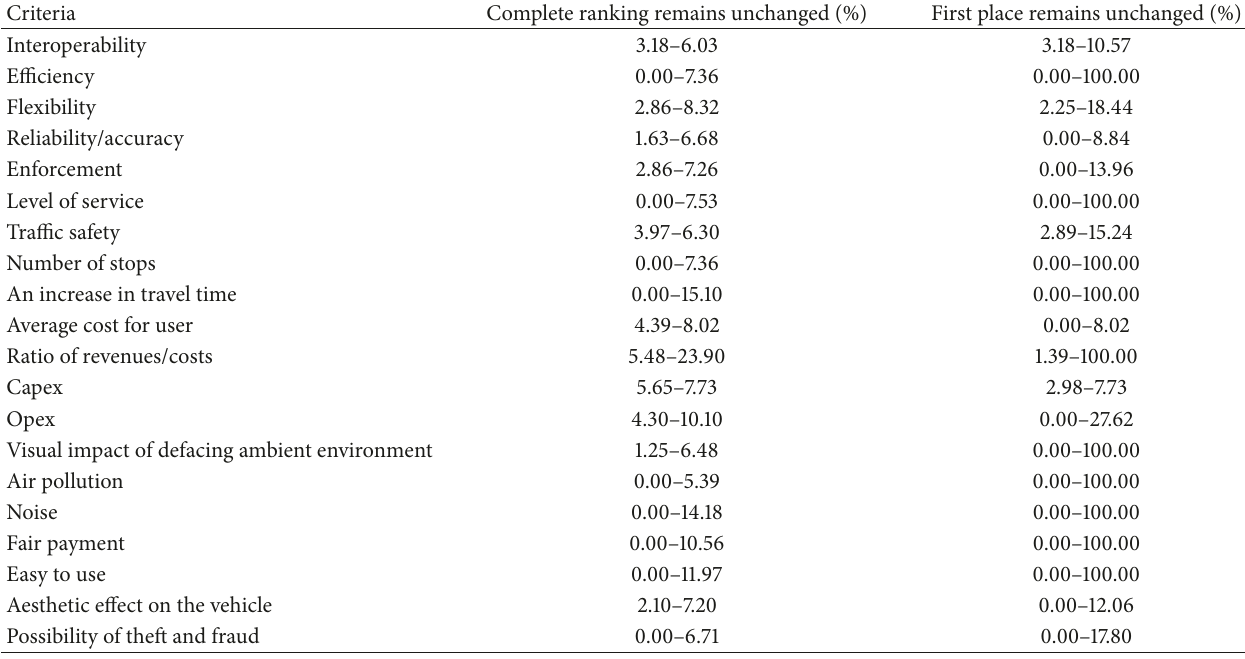
Table 11: Stability intervals matrix for criteria weight regarding the complete ranking and the first